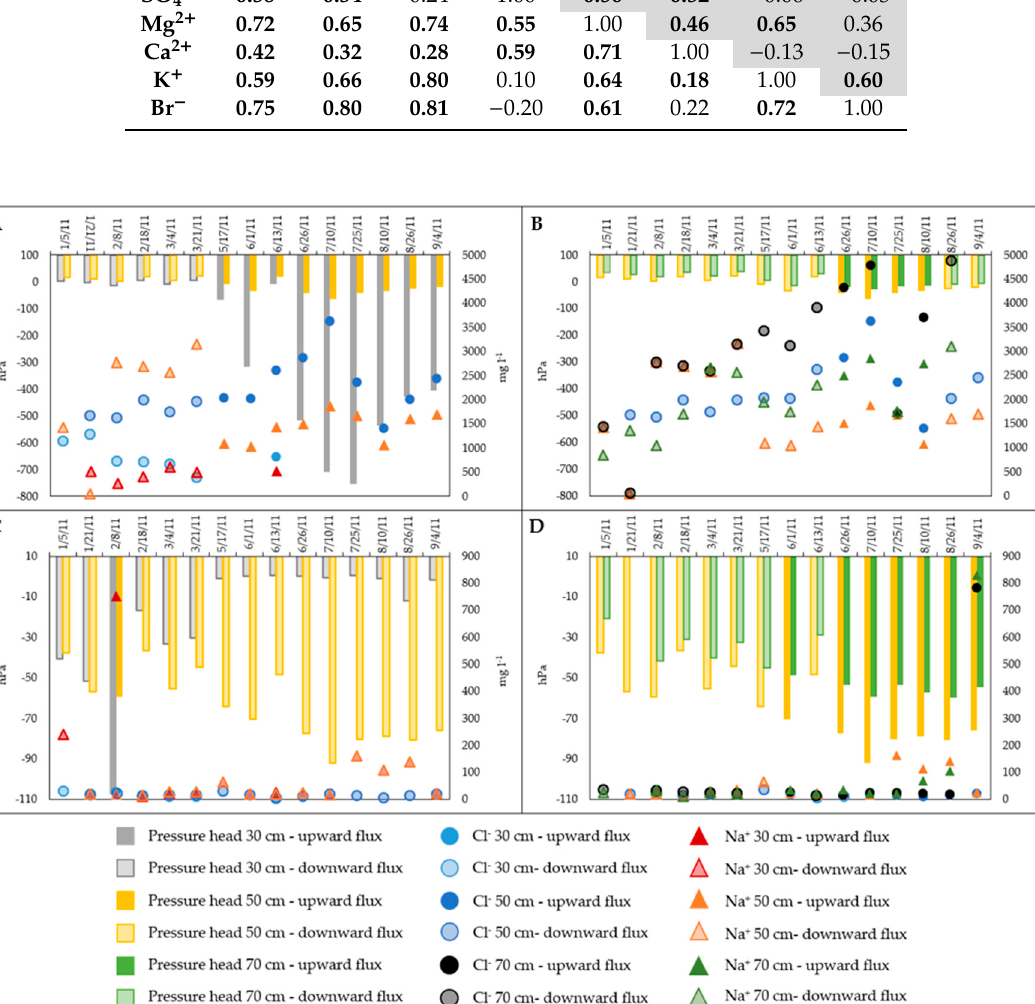
(Figure 3). The flux direction a ff ected EC and ion concentrations at station C (EC, p = 0.004; Cl